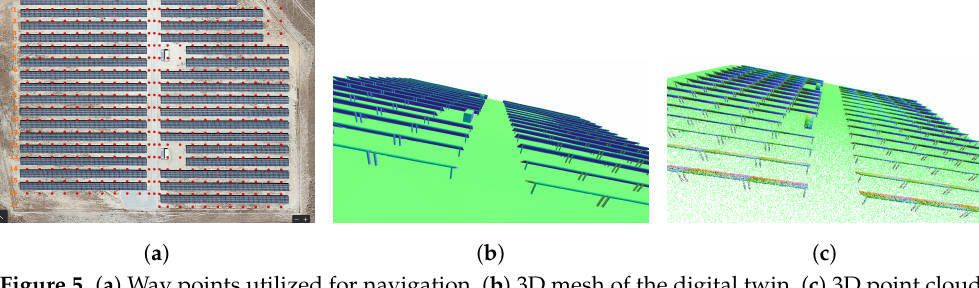
Figure 5. ( a ) Way points utilized for navigation, ( b ) 3D mesh of the digital twin, ( c ) 3D point cloud generated from the 3D